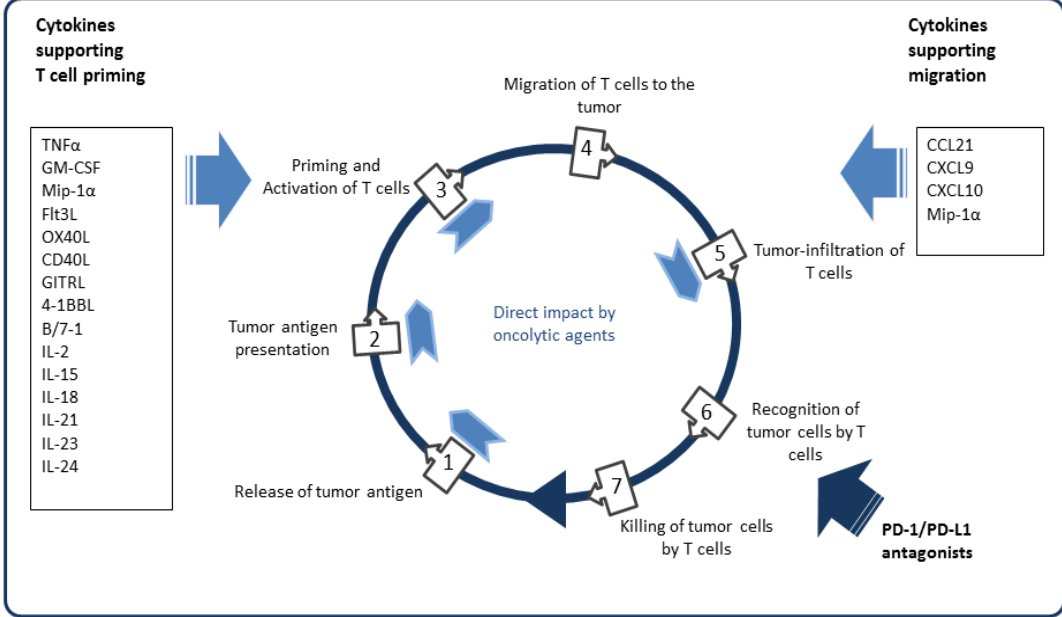
Figure 1. Immunostimulatory transgenes currently used in oncolytic adenoviruses in the context of the cancer immunity cycle.